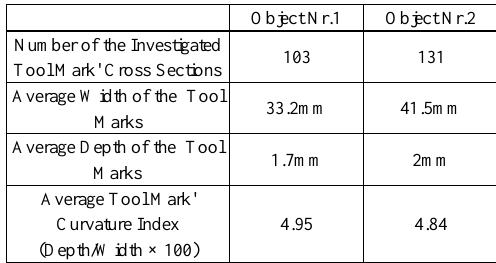
Table 2. Tool mark properties of the Bronze Age wooden